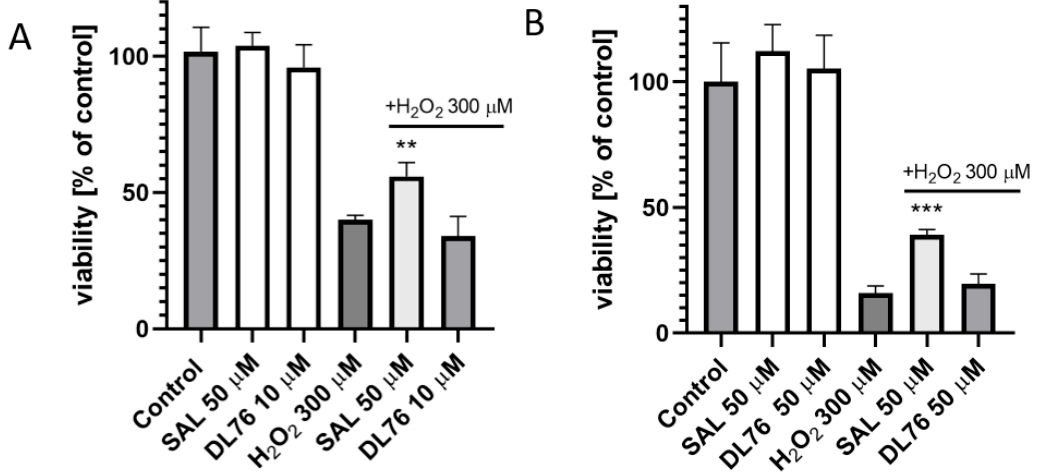
Figure 6. The effect of salsolinol (SAL) at 50 μ M and DL76 at 10 μ M ( A ) or at 50 μ M ( B ) on SH-SY5Y neuroblastoma cells viability damaged by 300 μ M of H 2 O 2 after 24 h of incubation: Statistical significance was set at *** p < 0.001 and ** p < 0.01 by GraphPadPrism™ 8 software using one-way ANOVA and Bonferroni’s multiple comparison posttest in comparison with the positive control H 2 O 2 (300 μ M).